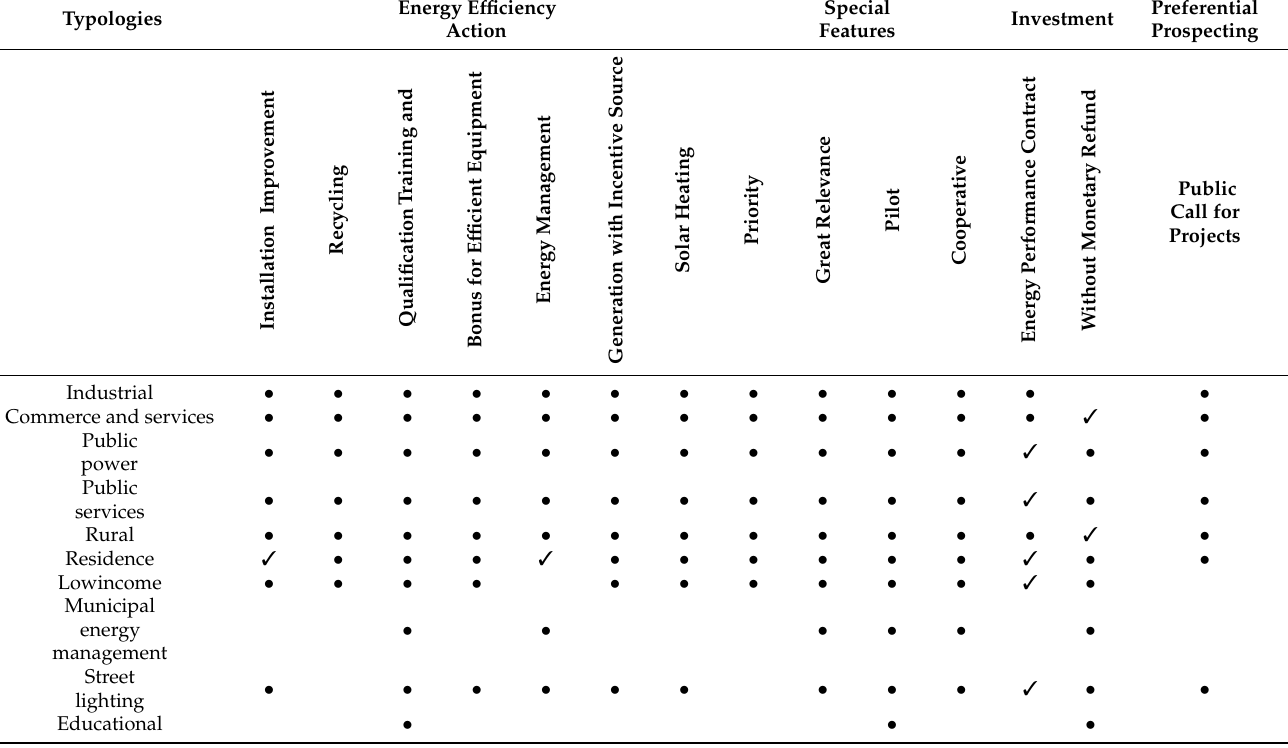
Table 2. Typologies and Characteristics of Energy Efficiency Projects